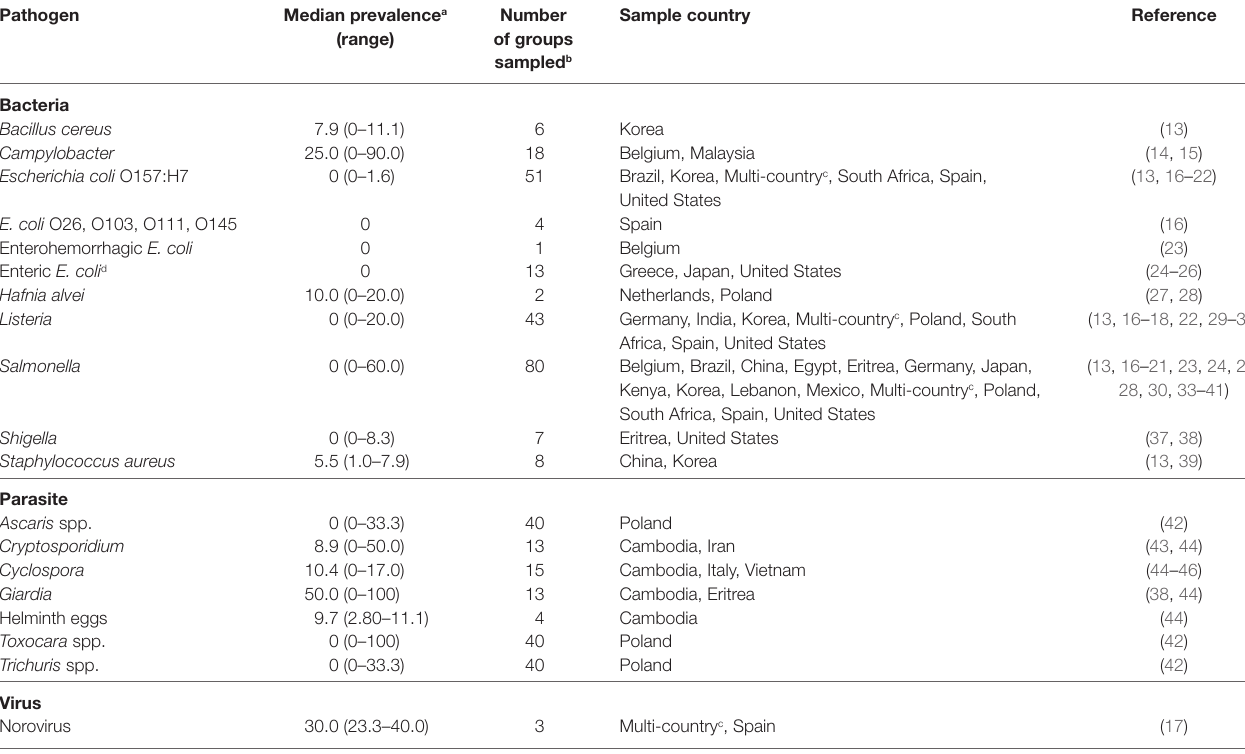
tabLe 2 | Prevalence of pathogens on produce from farms by pathogen type.